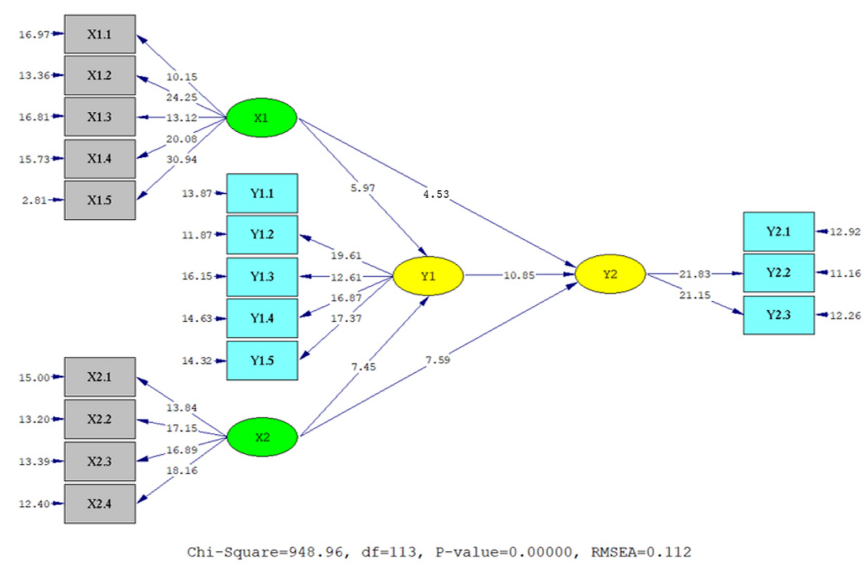
Figure 2. T-value structural model. Note: X 1 = EI, X 2 = AQ, Y 1 = OCB, Y 2 = Teachers’ professional competence.